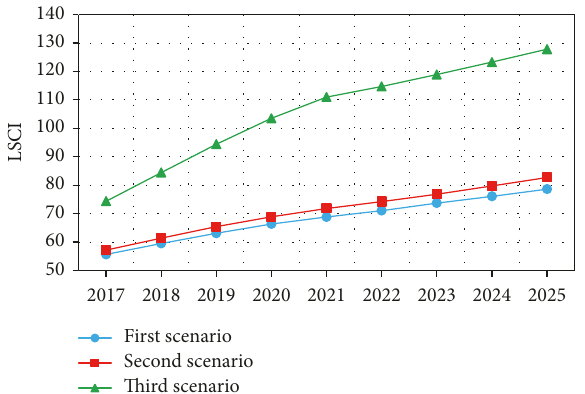
Figure 14: Trend of Iran’s LSCI during 2017 to